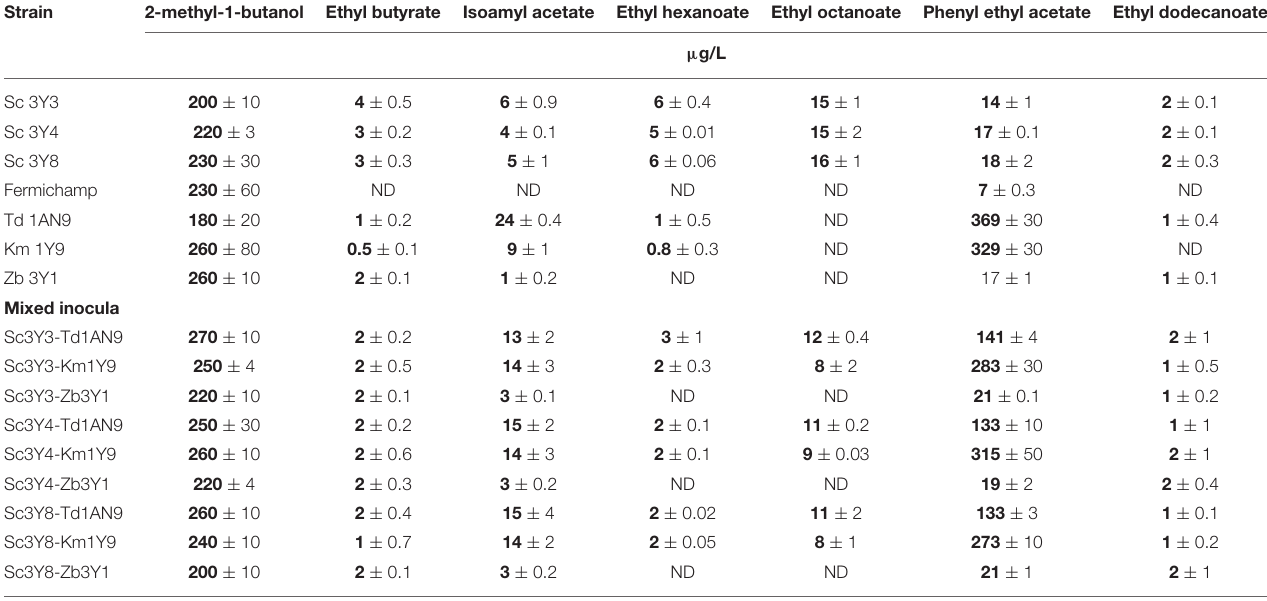
TABLE 5 | Volatile metabolite production for selected yeasts, fermenting as individual (upper panel) or mixed (lower panel) inocula fermentations, tested at 96h of fermentation in Agave medium.